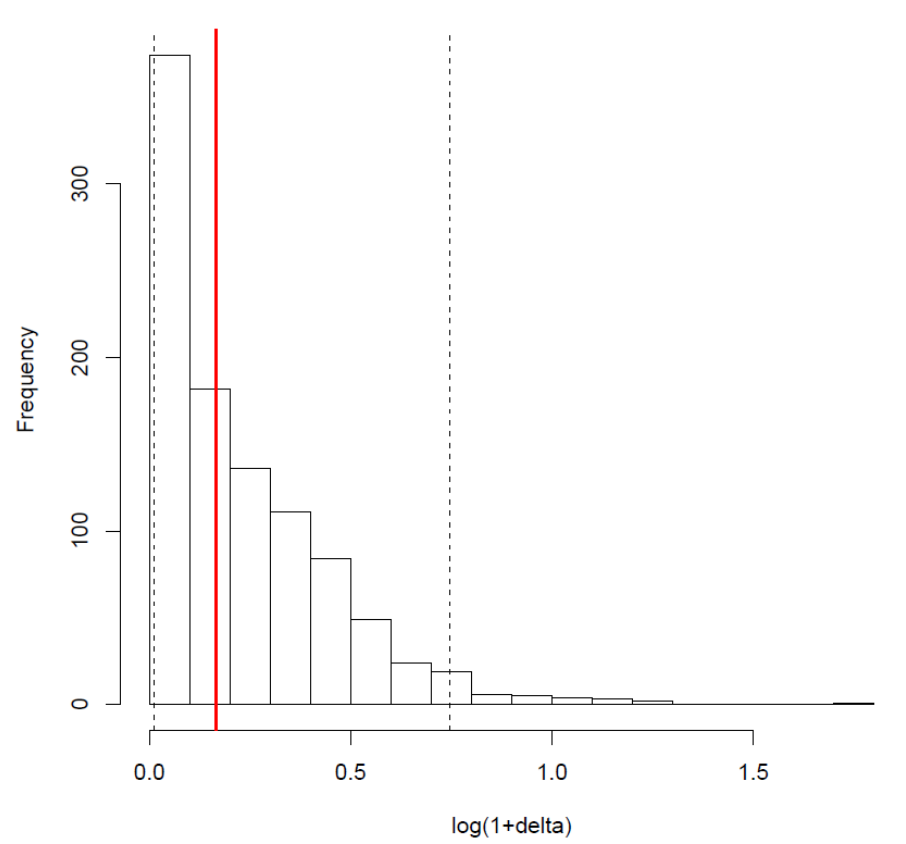
Figure A1. Distribution of the deltas with a random distribution of the model structure. Dotted black lines correspond to the 95% quantiles of the distribution. As the value of the phylogenetic signal found for the structure (red bar) is included in the 95% quantiles, there is no statistically significant phylogenetic signal.